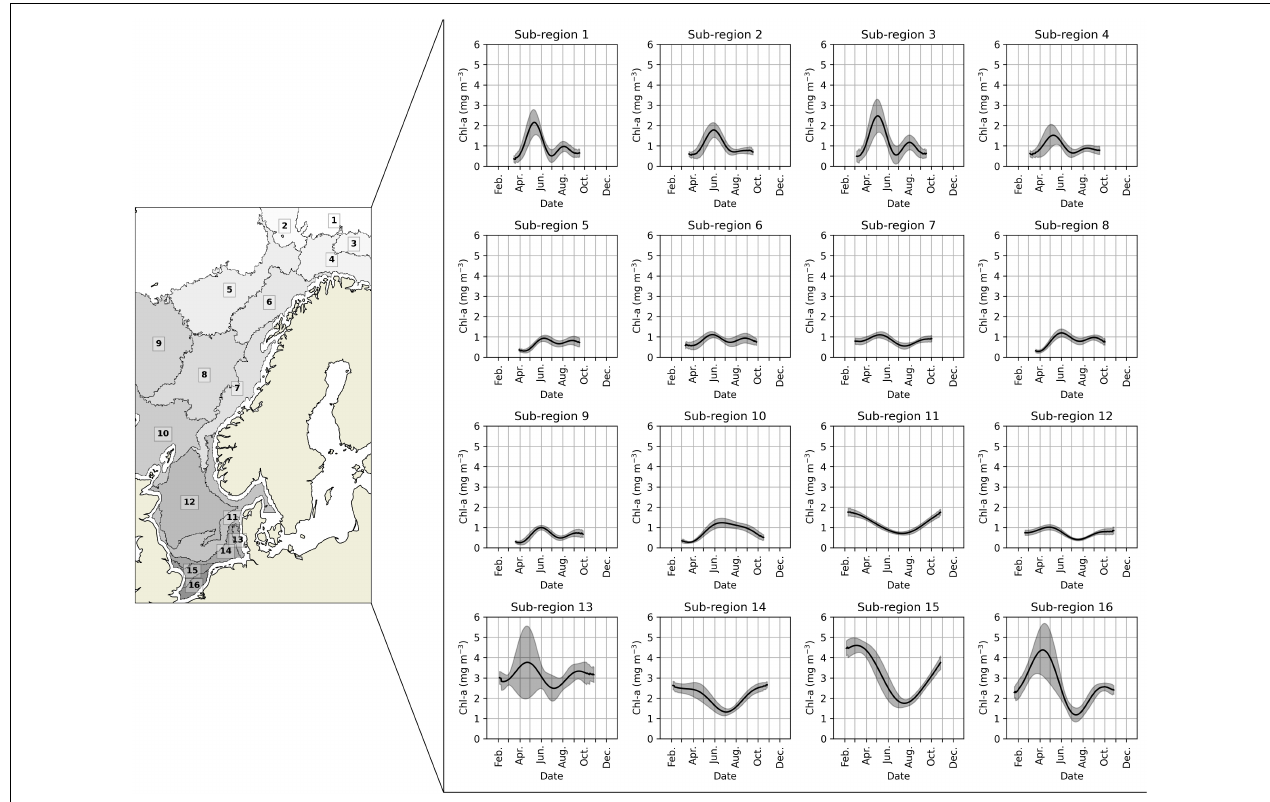
FIGURE 2 | The clustered sub-regions (left) and their annual Chl-a time series (right). The solid black line is the average over the period 2000–2020 and the shaded area is one standard deviation of the interannual variability.